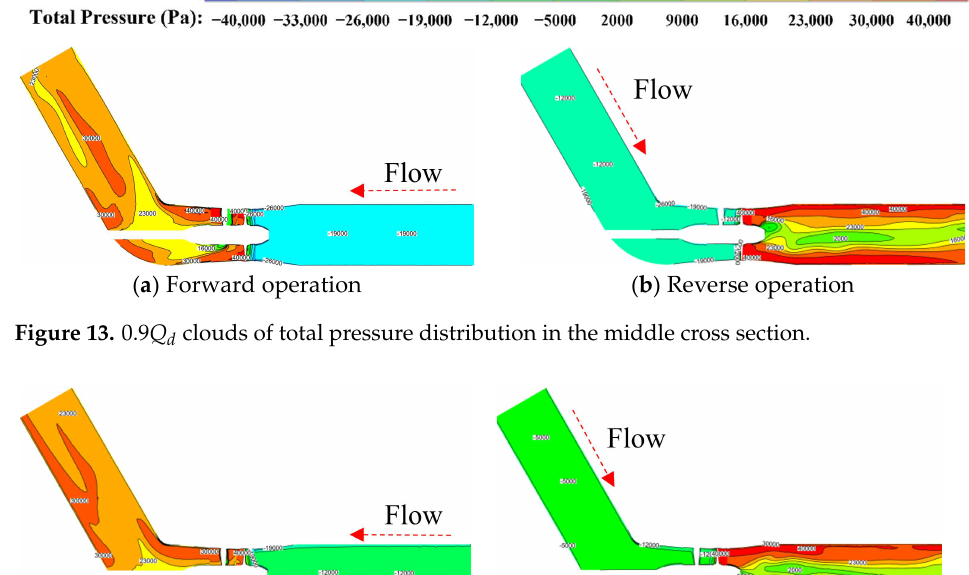
Figure 12. 1.1 Q d 3D streamline diagram.